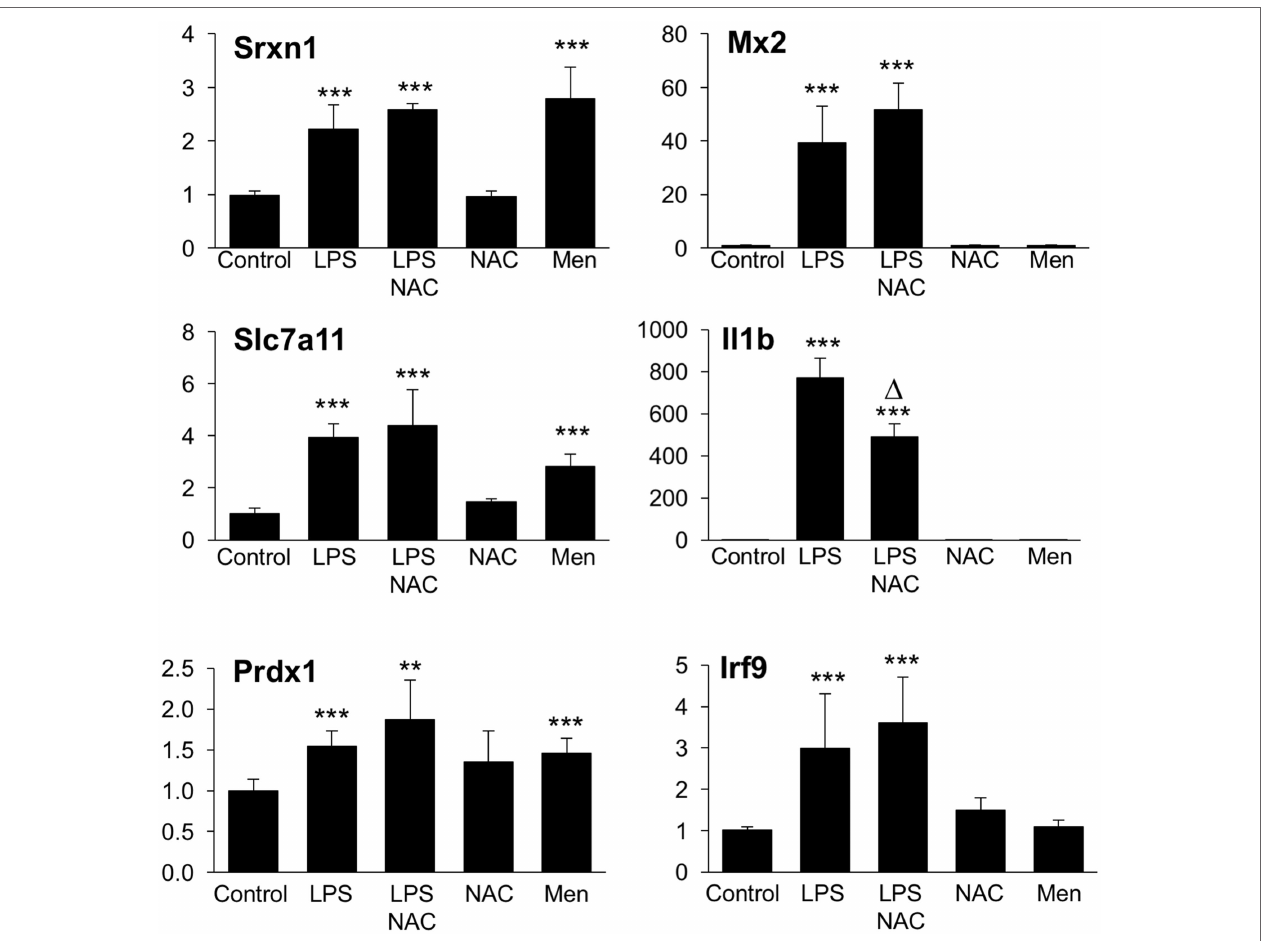
FigUre 9 | Effect of NAC and menadione on Group 1 (left) and Group 2 (right) genes. Cells were treated with 5 mM NAC for 1 h and then stimulated with 10 ng/ml LPS for further 2 h. Menadione (Men) was added at 10 µM for 2 h. Gene expression was measured by qPCR. Data are expressed as fold change vs one of the control samples, and are the mean ± SD of six biological replicates from two independent experiments. ** P < 0.01 and *** P < 0.001 vs control; Δ P < 0.01 vs LPS by two-tailed Student’s t -test. LPS, lipopolysaccharide; NAC, N -acetyl- l -cysteine; qPCR, quantitative polymerase chain reaction.